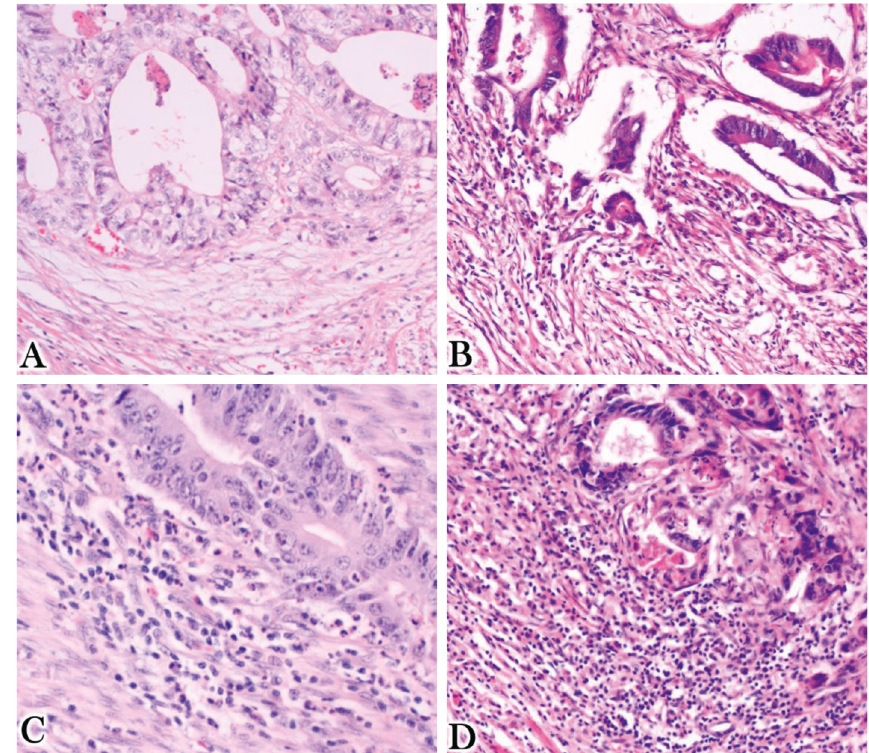
Figure 1: Microphotographs illustrating the inflammatory response:(a) score 0, (b) score 1, (c) score 2, and (d) score 3. For interpretation, scores 0 and score 1 are considered low immune reaction, while score 2 and score 3 denote a high immune